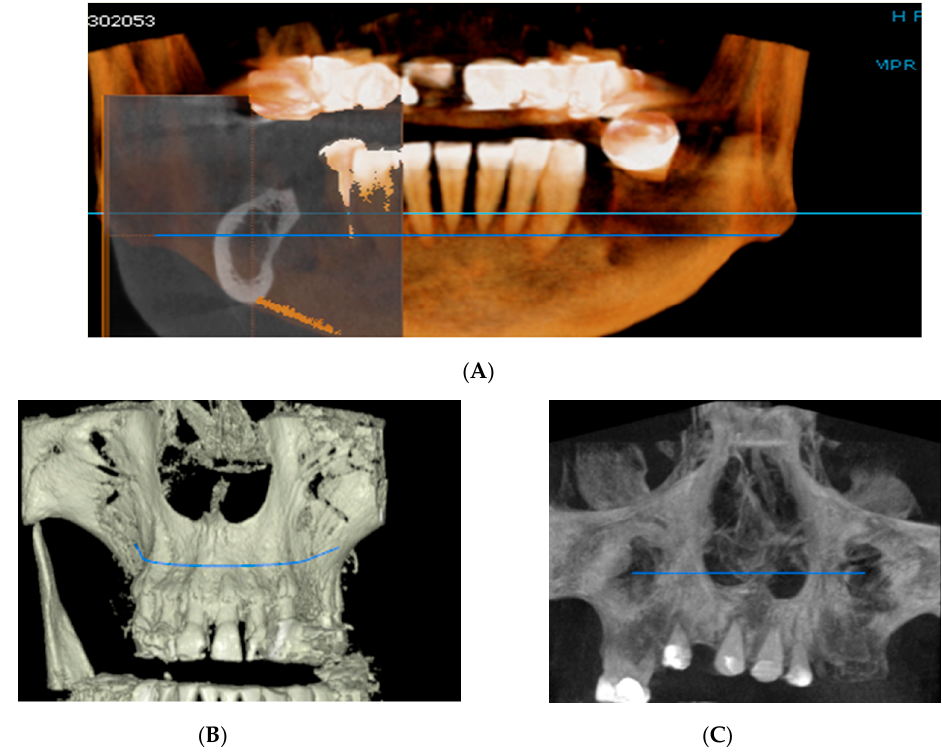
Figure 2. Rendering images showing field of view (FOV) images used in the study. ( A ), Frontal view, ( B ), Frontal Bone view, ( C ), X-ray view.